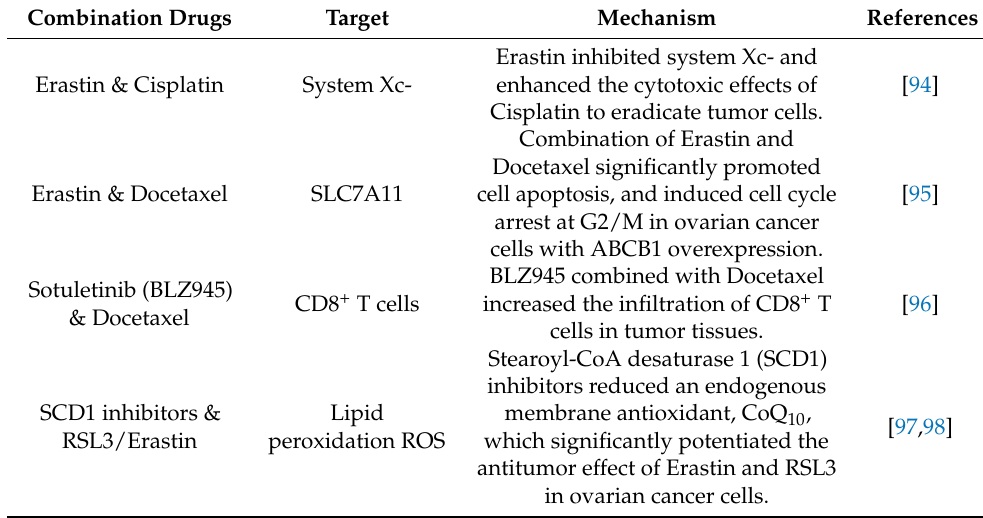
Table 1. Summary of studies on ferroptosis inducers in ovarian cancer. The anticancer effects of the chemotherapeutic or targeted therapeutic drugs are enhanced upon combination with ferroptosis